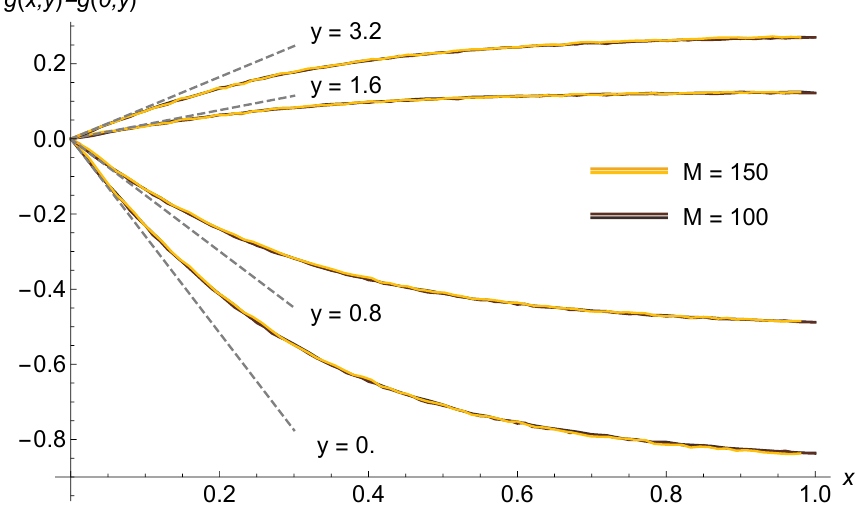
Figure 10: Plot of the same data as in figure 7, subtracted as explained in figure 8. Straight dashed lines have the same significance as in figure